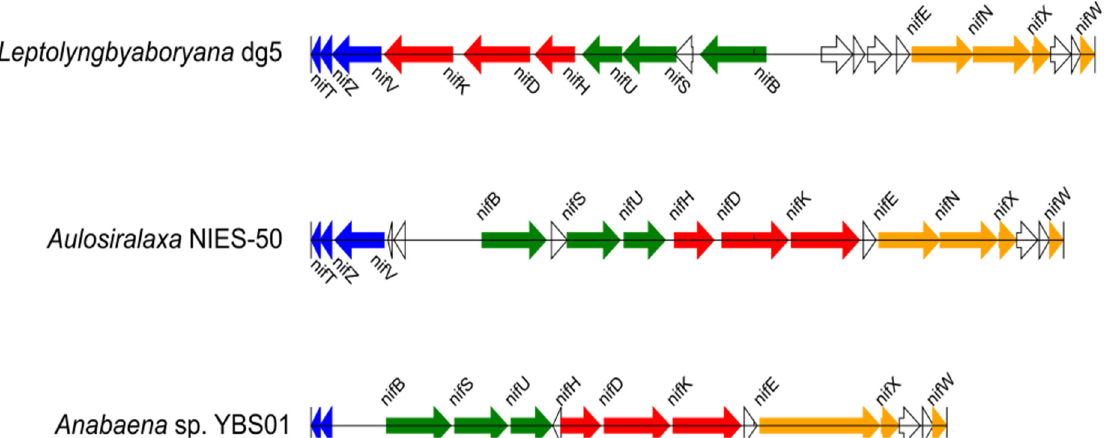
Figure 2. Operon structures of Cyanobacteria nif genes. The nif operon structures of Leptolyngbya boryana dg5, Aulosira laxa NIES-50, and Anabaena sp. YBS01 are shown. Blue, red, green, and orange arrows indicate the nifVZT, nifHDK , nifBSU , and nifENXW operons, respectively. White arrows indicate the genes unrelated to nitrogen fixation.